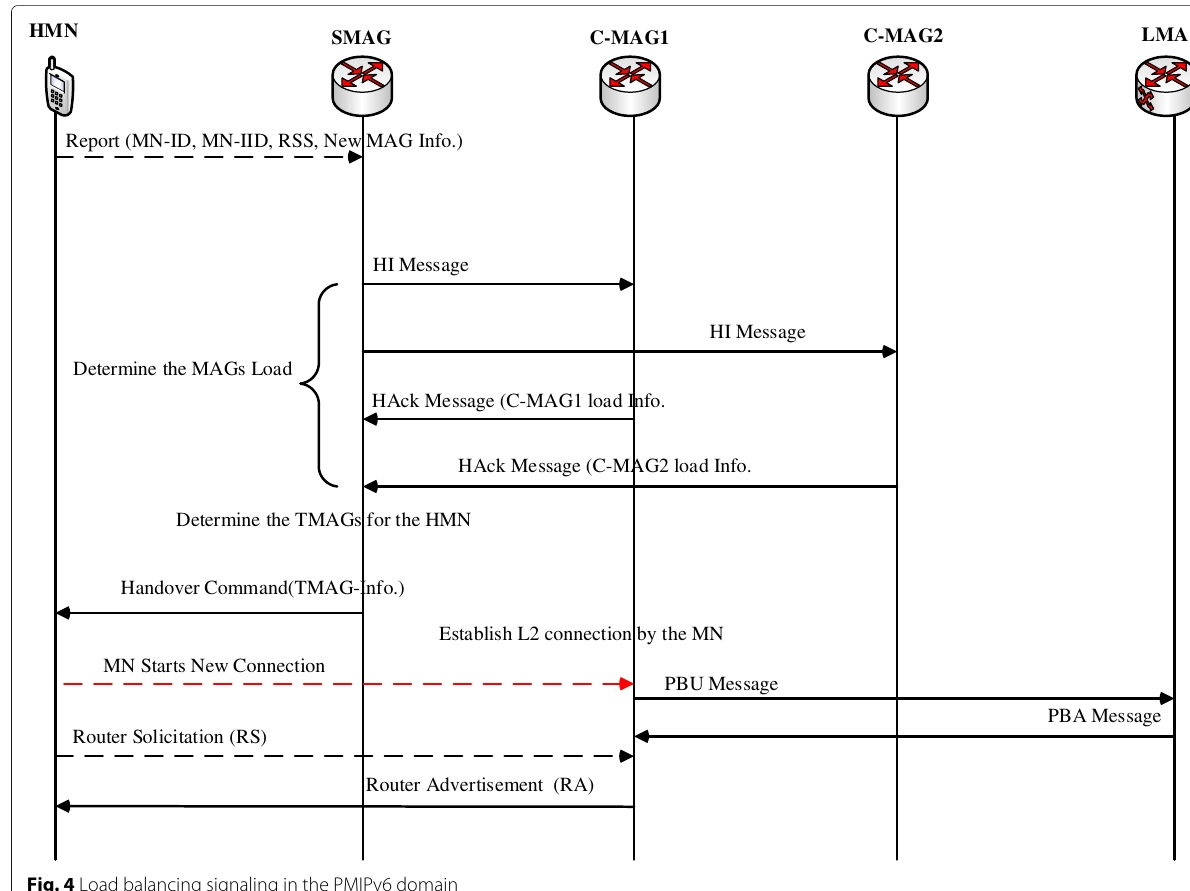
to collect the similar data packets which require some sig- naling messages between the MN and the associated